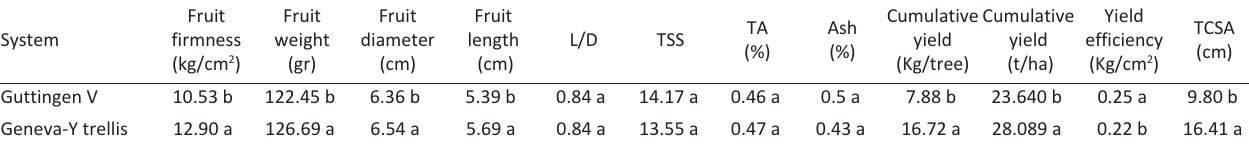
Means with same letters are not significantly different. (P>0.05) using Duncan Multiple Range